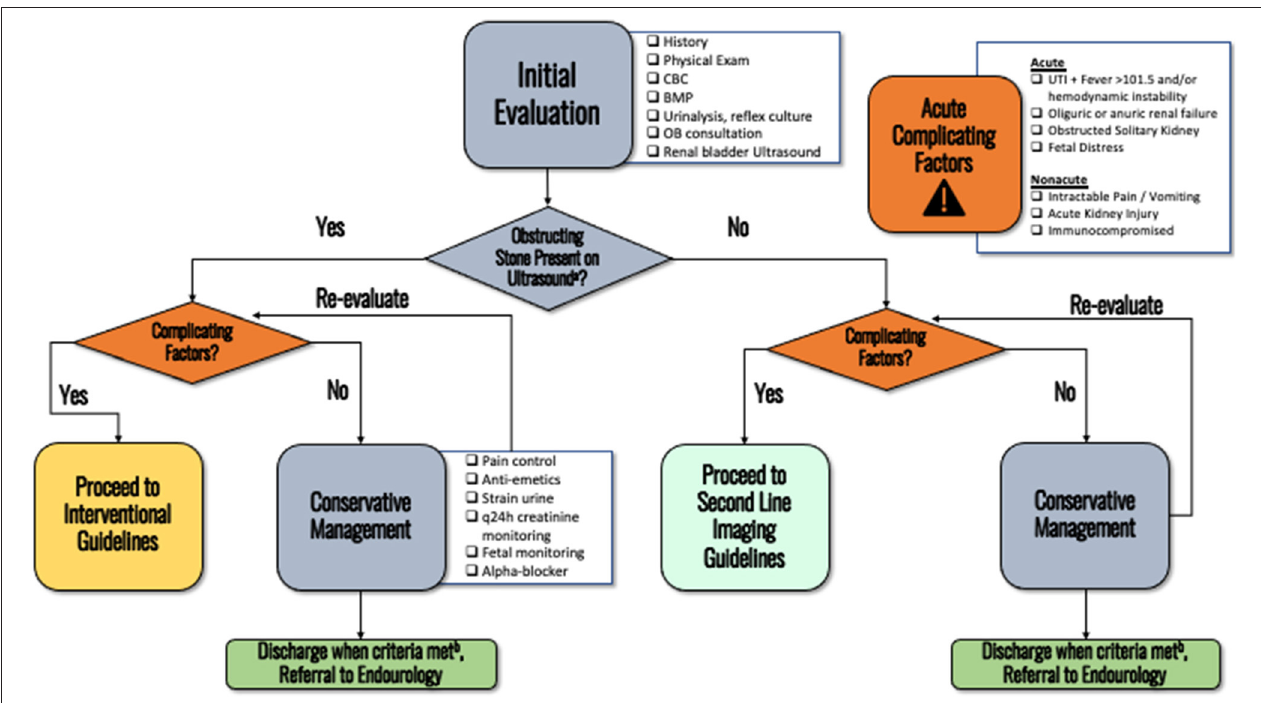
FIGURE 1 | The initial evaluation of an obstetric patients presenting with nephrolithiasis. (a) Pain is adequately controlled on oral pain medications, nausea well controlled and able to eat/drink, no AKI and stable creatinine, afebrile, non-concerning fetal monitoring. (b) When more emergent diagnosis is not needed. Consider performing doppler for RI, ureteral jets, or transvaginal ultrasonography (if distal stone suspected) if not already performed on initial